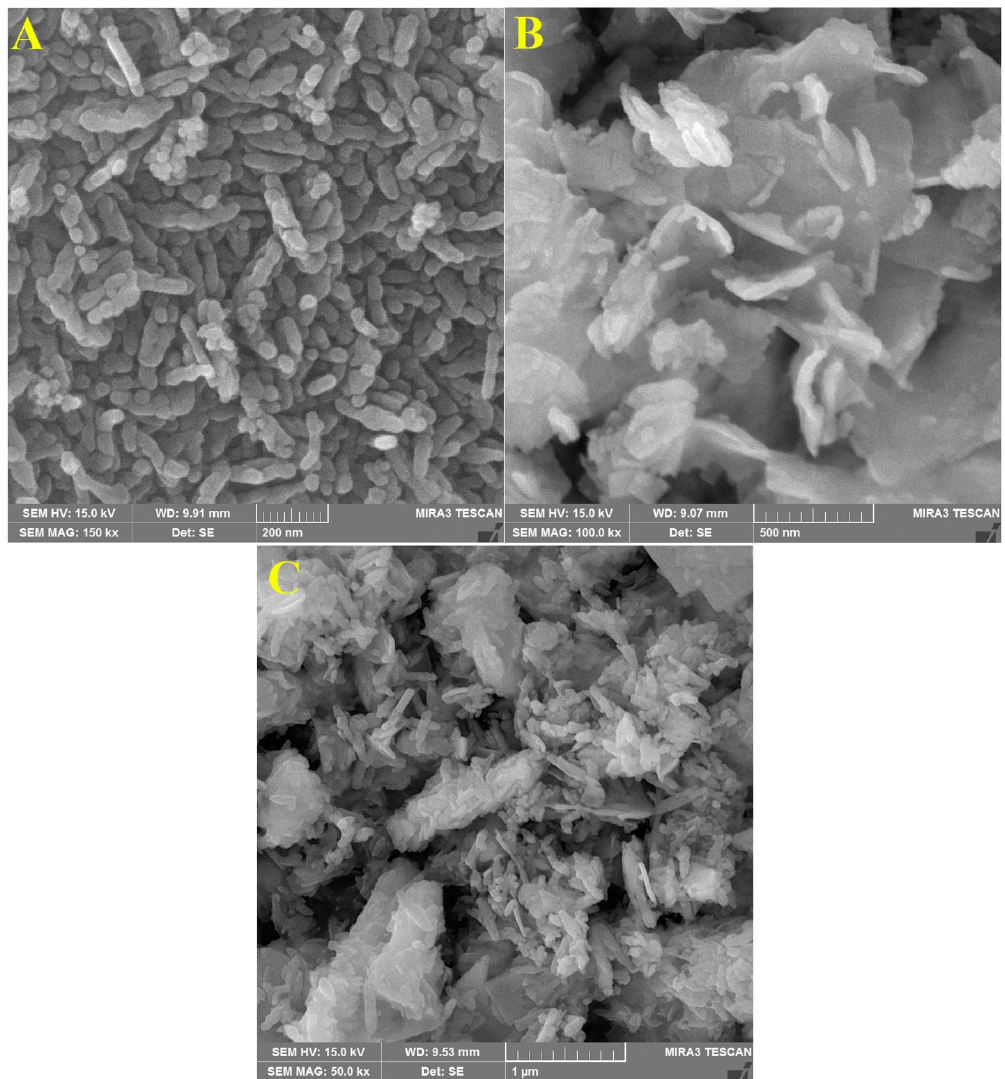
Fig. 2. FE-SEM images of TiO